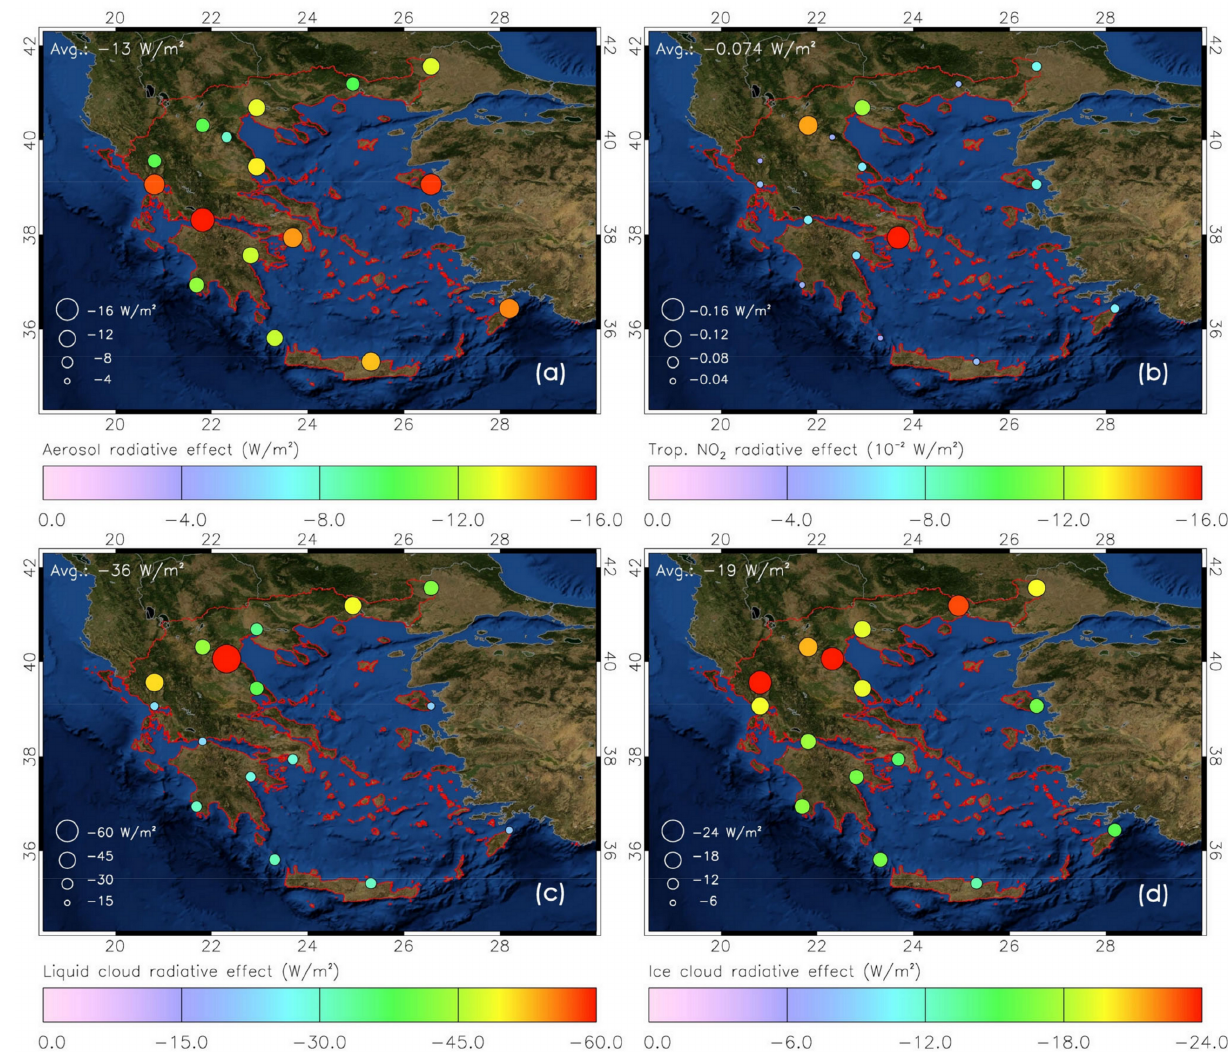
Figure 4. Annual average radiative effect of ( a ) aerosols, ( b ) tropospheric NO 2 , ( c ) liquid clouds and ( d ) ice clouds over 16 locations in Greece for the period 2005 − 2019. Mind that a different scale is used for the radiative effect of each parameter and that the radiative effect of tropospheric NO 2 is smaller by two orders of